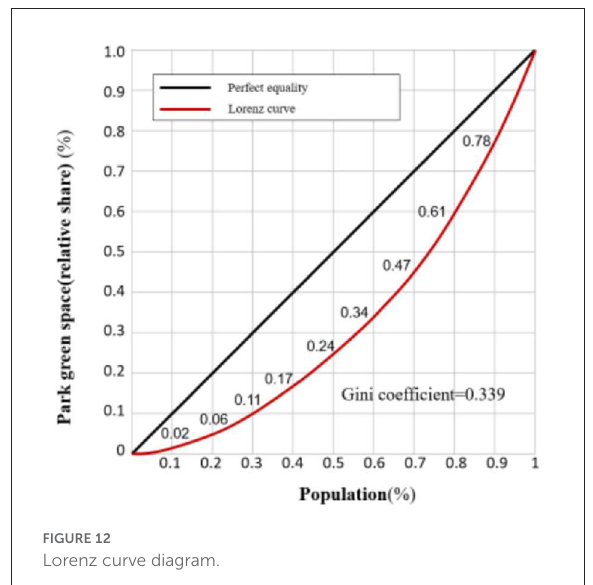
FIGURE12 Lorenz curve diagram.